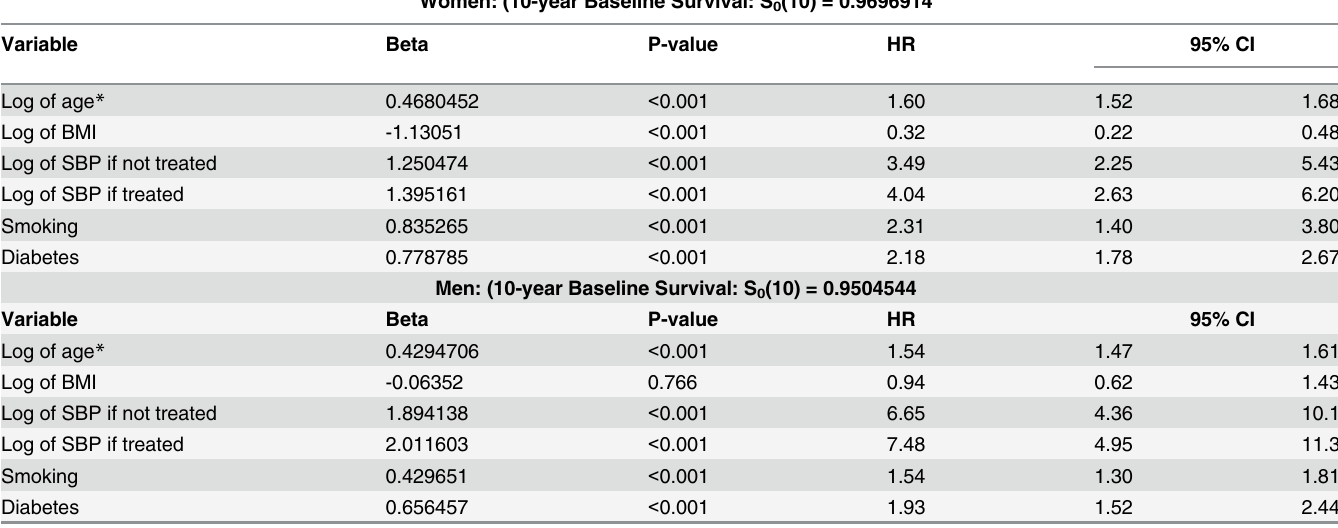
Table 2. Regression coefficients and hazard ratios for CVD